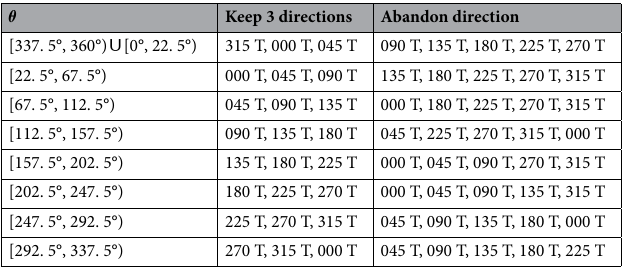
Table 1. Three-direction rule table.